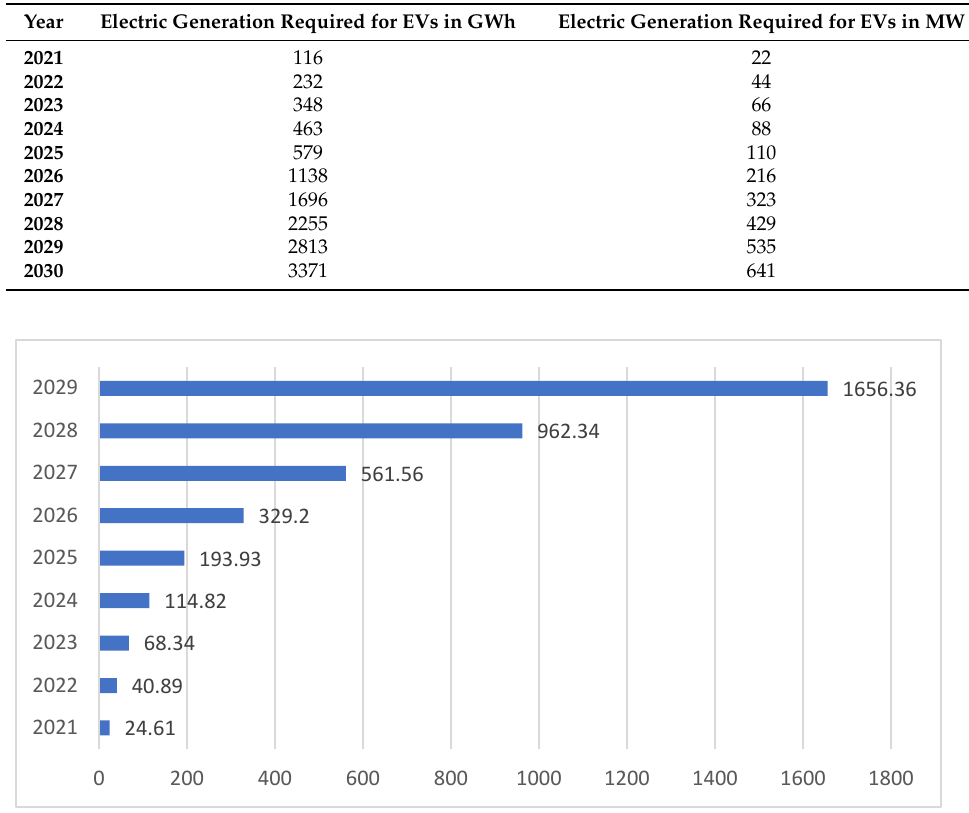
Figure 8. Revised EV electricity consumption 2021 – 2030.